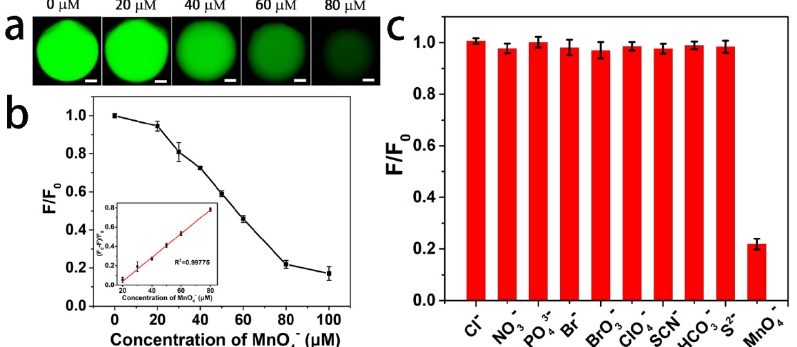
Figure 5. ( a ) Fluorescence microscope images of the autofluorescent BSA hydrogel microspheres in the presence of MnO 4 − at different concentrations (pH = 3) (All the scale bars are 10 μ m); ( b ) the concentration titration curve between F/F 0 and the concentration of MnO 4 − (inset figure: linear relationship between (F 0 − F)/F 0 and the concentration of MnO 4 − ); ( c ) relative fluorescence intensity of the autofluorescent BSA hydrogel microspheres after being exposed to various analytes (the concentration of all the anions was set at 80 μ M). The error bars represent the standard deviation of three measurements.